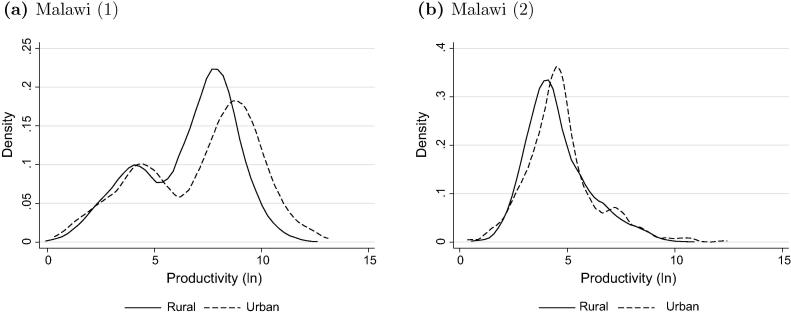
Productivity dispersal – by location. Note(s): In (a) and (b) the continuous lines represent the productivity of rural enterprises and the dotted lines the productivity of urban enterprises. Malawi (1) shows the productivity measure using profit in the numerator, and Malawi (2) additionally makes use of time-use information of workers in the denominator.